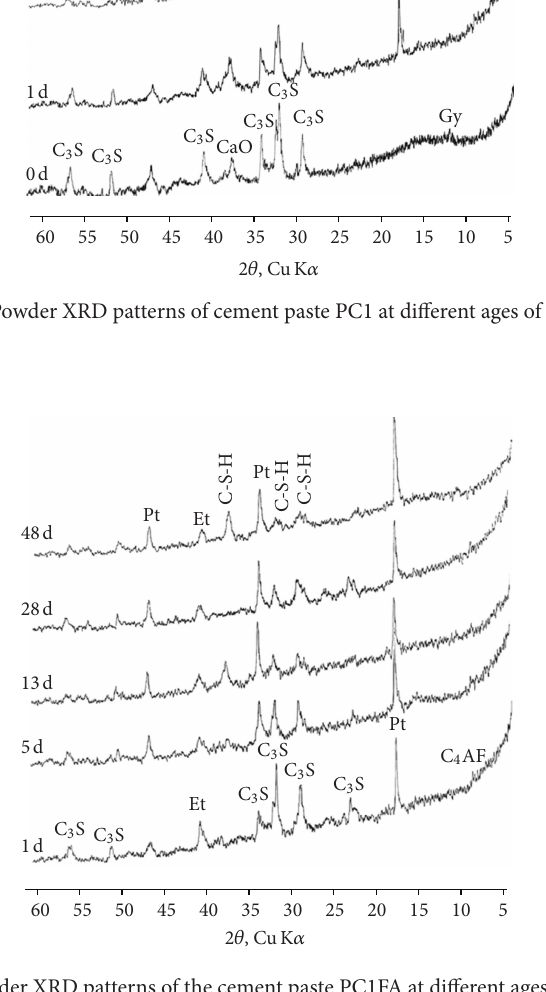
F 3: Powder XRD patterns of the cement paste PC1FA at different ages of hydration.